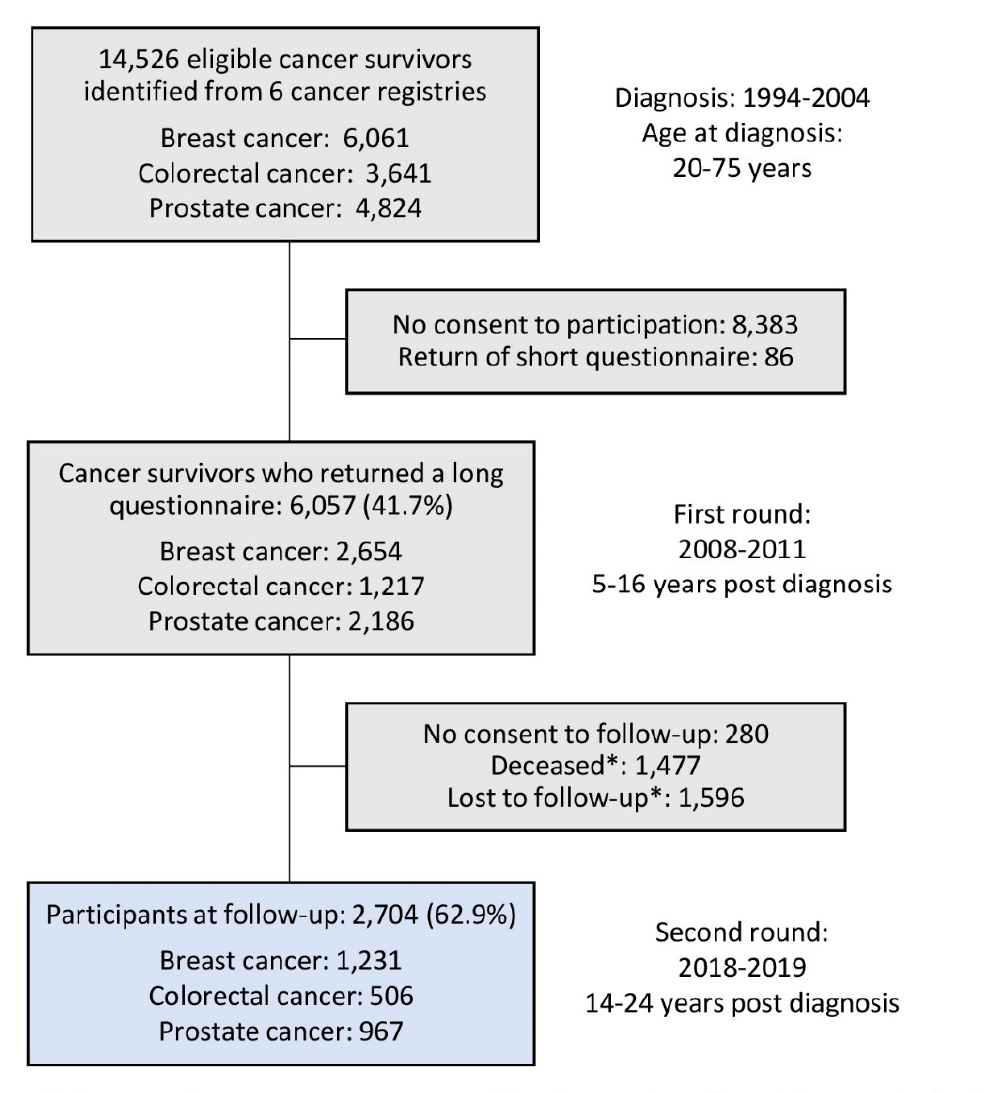
Figure 1. Flowchart of the CAESAR study (initial and follow-up survey).